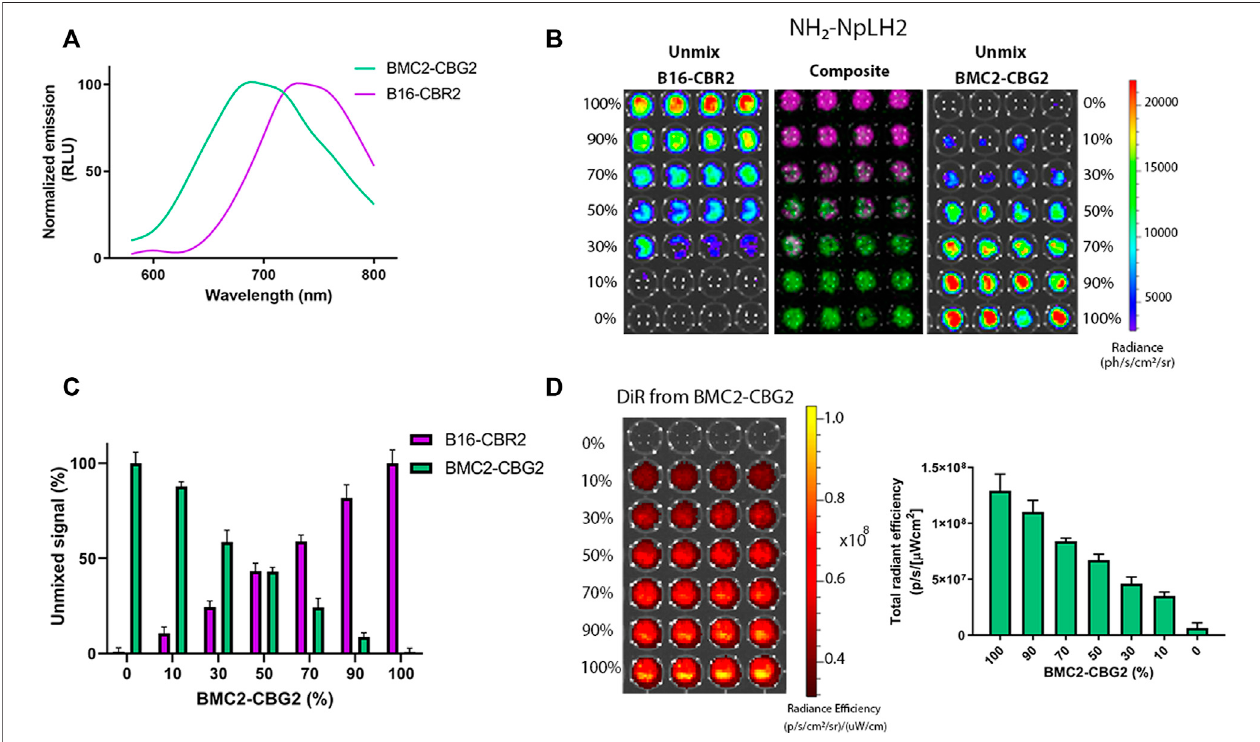
FIGURE 1 | In vitro characterization and spectral unmixing of BMC2-CBG2 and B16-CBR2 luciferase-expressing cells. (A) Normalized bioluminescence emission spectraforBMC2-CBG2andB16-CBR2cellstreatedwithNH 2 -NpLH2luciferinastheluciferasesubstrate.Spectrawerenormalizedtothepeakemissionforeachclick beetle mutants with the NH 2 -NpLH2 substrate. Spectra were acquired using an IVIS spectrum imager with the following settings: FOV C, f/stop = 1, medium binning, 30 sexposuretime,and arangeofbandpass fi ltersranging from580to800 nm. (B) Spectral unmixing ofB16-CBR2 andBMC2-CBG2 cells( n =4samples).Cells were mixed in various proportions ranging from 100 to 0% cell number of the total population. Quanti fi cation of the BL unmixed outputs for B16-CBR2 (magenta color) and BMC2-CBG2 (green color) registered after NH 2 -NpLH2 substrate administration. A black 96-well plate was spectrally imaged using a selected bandpass fi lter ranging from 580 to 800 nm by using an IVIS spectrum imager. (C) Quanti fi cation of the percentage of unmixed signals of B16-CBR2 and BMC2-CBG2 cells ( n = 4 samples).Unmixedsignalswerenormalizedto100%cellratioswith p < 0.0001calculatedbymultiplecomparisonsandone-wayANOVA.Errorbarsrepresent±SD. (D) Radiant ef fi ciency was recorded for BMC2-CBG2 macrophages pre-labeled with the DiR near-infrared fl uorescent dye. Cells were plated in a black 96-well plate in variousproportionsrangingfrom0to100%ofthetotalpopulation.Thebargraphshowsthemean fl uorescenceintensity.Errorbarsrepresent±SD( n =4samples).The plate was spectrally imaged using an IVIS imager system, and DiR fi lters were set at 710 nm for excitation and 760 nm for